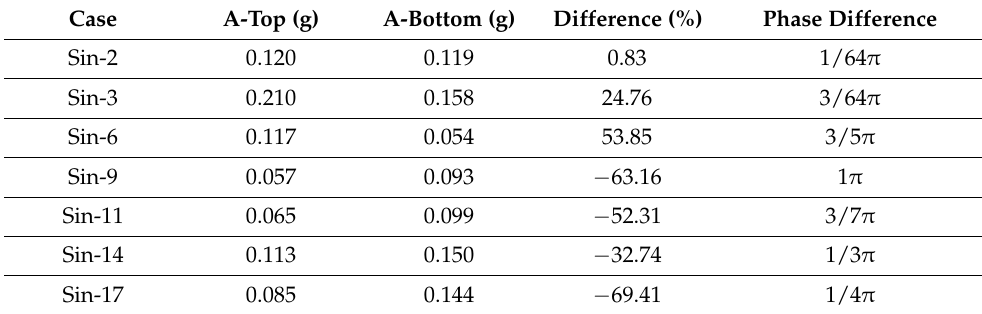
Table 9. Peak acceleration on